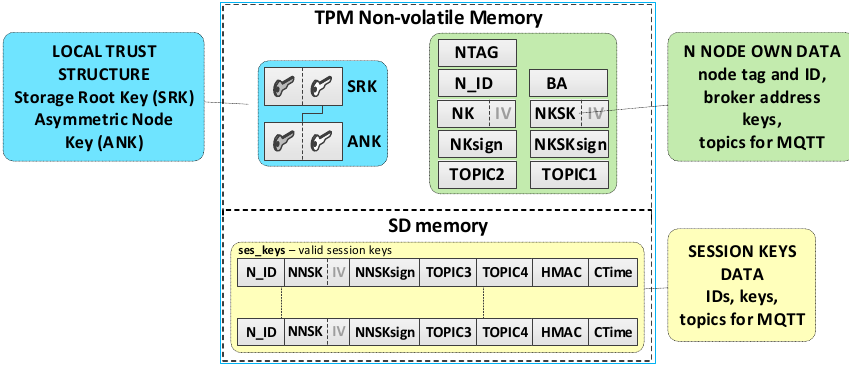
Figure 6. Data stored on the N node.